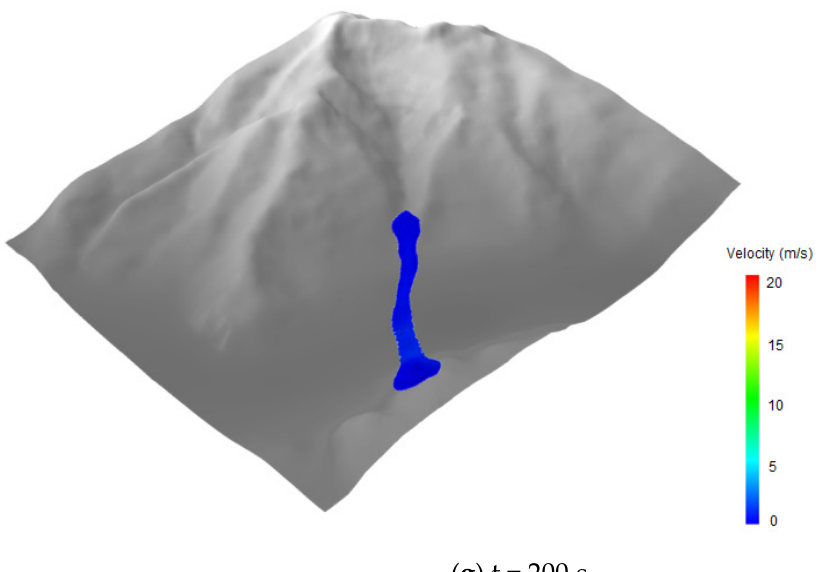
Figure 10. Velocity variations in the Yigong debris flow.